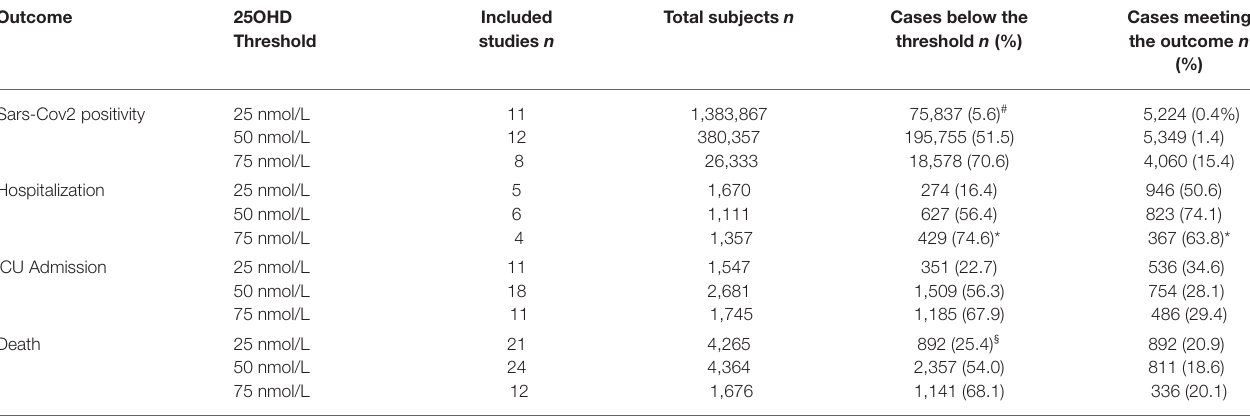
TABLE 2 | Number of included studies and sample size considered for each specific outcome, in relation to the 25OHD thresholds of 25, 50, and 75 nmol/L. Outcome 25OHD Included Total subjects n Cases below the Cases meeting Threshold studies n threshold n (%) the outcome